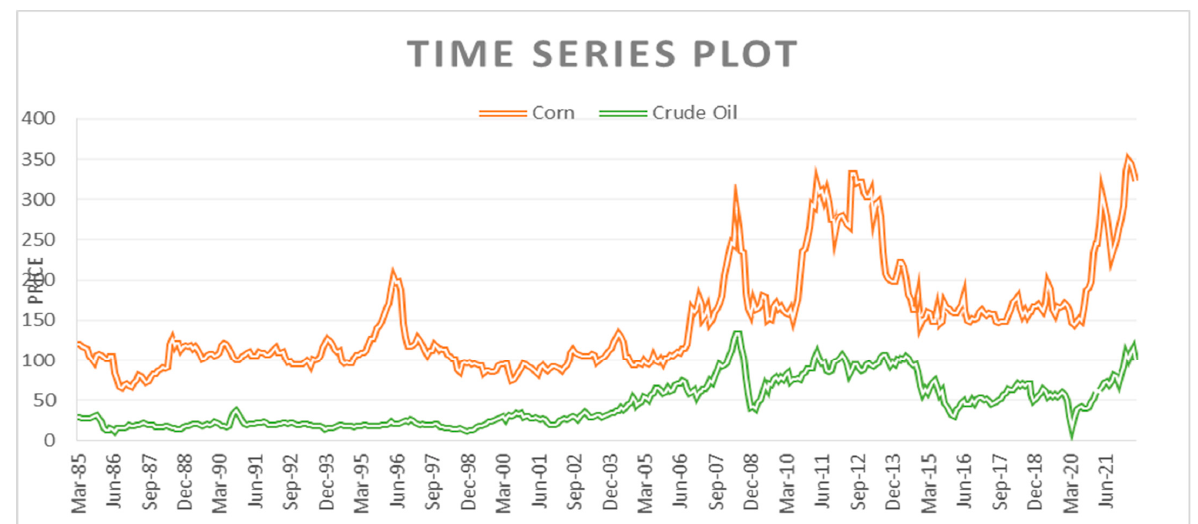
Figure 3. Time-Series Plot of Crude Oil and Iron Ore Price Patterns.